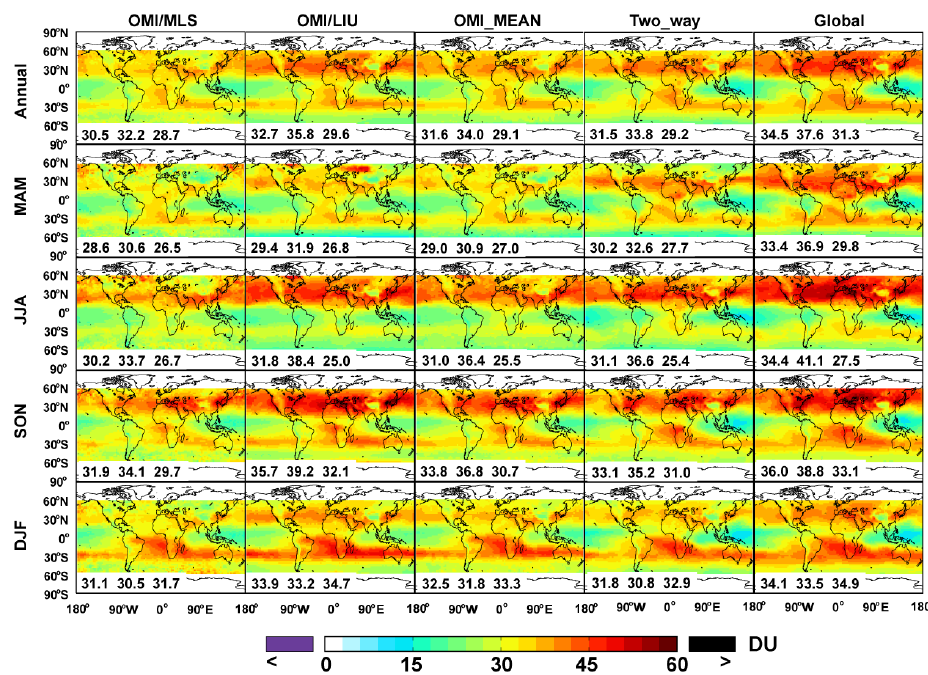
Figure 9. Measured and modeled annual and seasonal mean tropospheric ozone columns from 60 ◦ S to 60 ◦ N in 2009: (from left to right) OMI/MLS, OMI retrieval by Liu et al. (2010), average of the two satellite data sets, simulation of the two-way coupled system, and simulation of the global model alone. Also shown in each panel are global, NH and SH